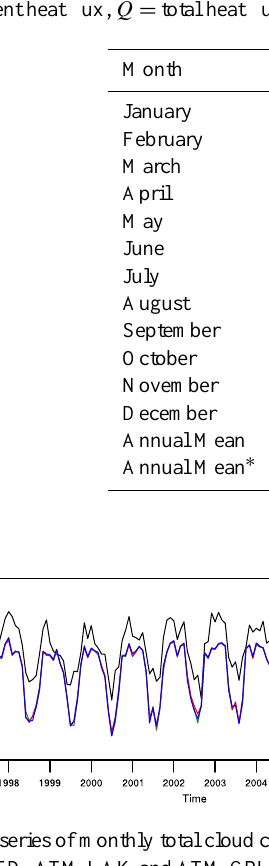
Table 2. Lake averaged monthly mean heat flux components (Wm − 2 ) at the sea surface for the period 1996–2008 from the ATM.CPL simulation. The Q s = incoming solar radiation, Q b = (long wave) thermal radiation, Q s + Q b = total radiative heat flux, H = sensible heat